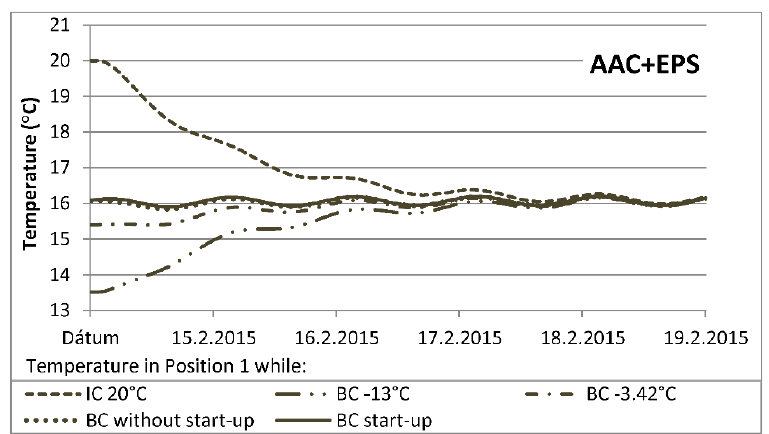
Figure 11. Temperature profile across the simple AAC test wall at time t = 0 h, t = 12 h and t = 24 h for five cases under the initial condition. Abbreviations IC and BC refers to Section 2.4.